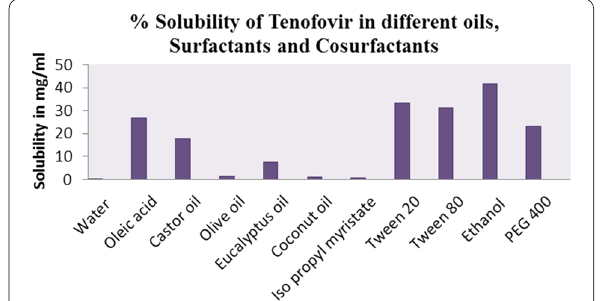
Fig. 1 Solubility of TNF in different oils, surfactants, and